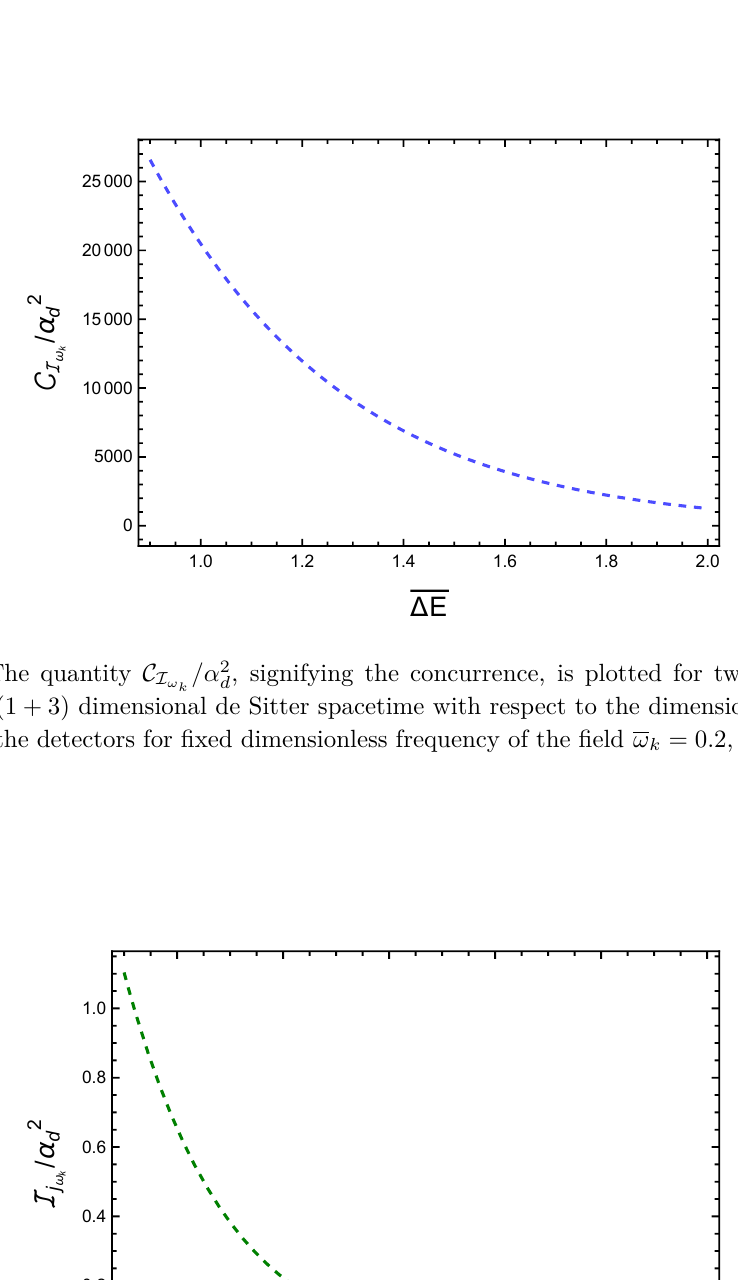
is plotted for two outgoing null detectors in a (1+3) dimensional Figure 23 . The quantity I j /α 2 d ωk de Sitter spacetime with respect to the dimensionless transition energy ∆ E of the detectors for fixed ω k = 0 . 2 , and k x = ω k / 2 . This plot is valid for all the d/α d